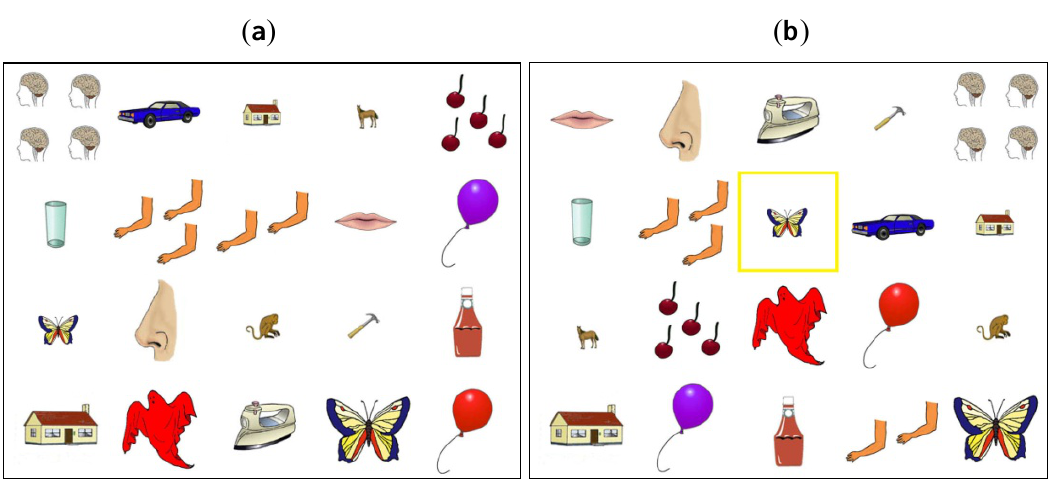
Figure 2. Example scene for a contrast-present trial from ( a ) the speaker’s perspective and ( b ) the listener’s